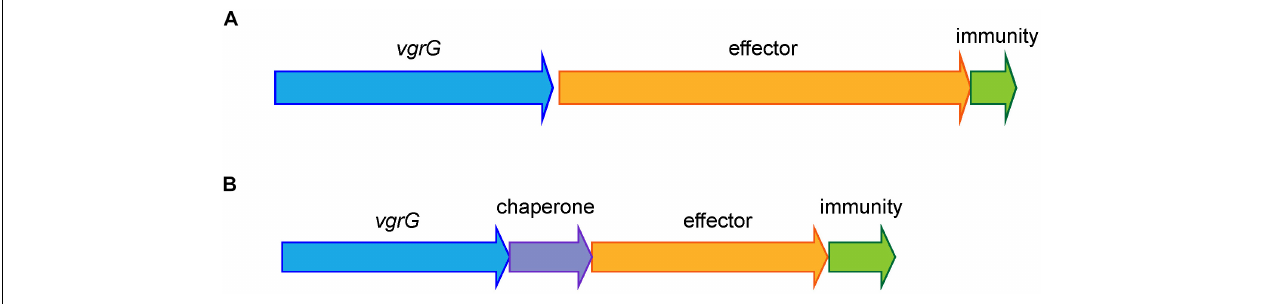
FIGURE 1 | Shematic representation of the common organization of A. baumannii T6SS effector loci. The most common arrangement is a three-gene locus comprising a VgrG-encoding gene, followed by a gene encoding the toxic effector and a gene encoding the cognate immunity protein (A) and the less common arrangement is a four-gene locus comprising a VgrG-encoding gene, followed by a gene encoding a chaperone then a gene encoding a toxic effector and a gene encoding a cognate immunity protein (B) .